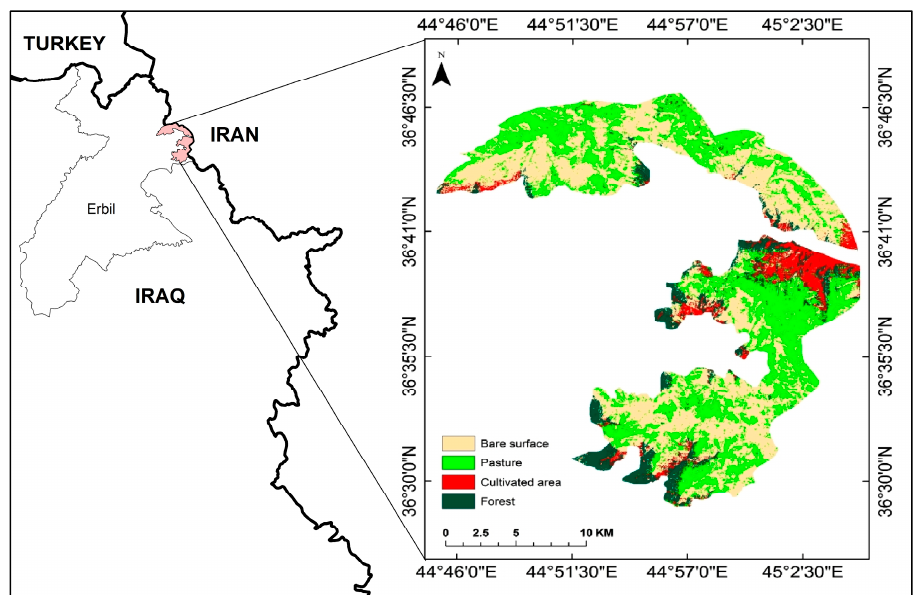
Figure 1. Location map of Halgurd Sakran Core Zone (HSCZ) in the Kurdistan Region of Iraq.